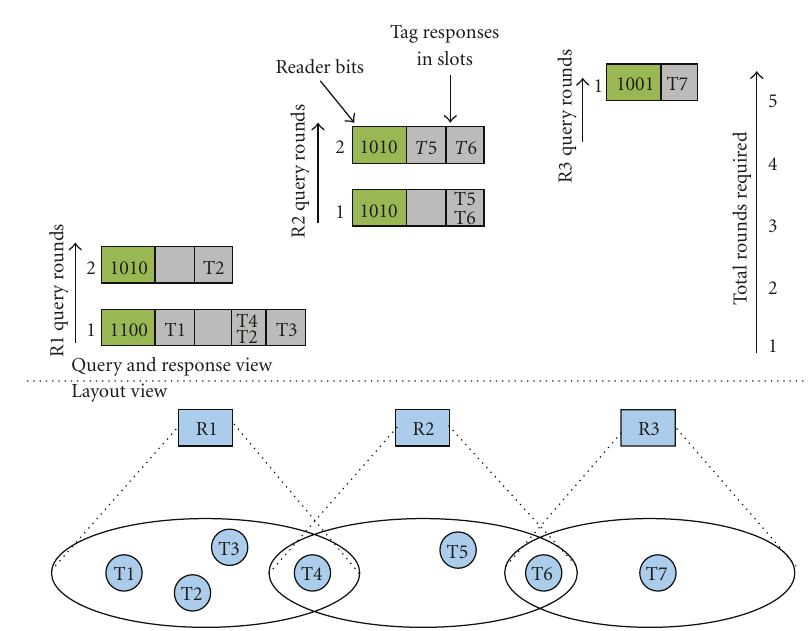
Figure 5: Working example of sequential operation of three readers. The lower part of figure shows the layout of readers and tags within the read range of each. The upper part shows in detail the progression of reading tags as the readers operate one by one in the order R1, R2, and then R3. In a query round, each reader sends a query of bits and awaits responses over a frame of time slots. Each reader chooses its query independently based on its estimate of tags in its reading range. All tags are read after a total of 5 rounds of querying requiring 11-tag response time slots (4,2,2,2,1 in those rounds) in